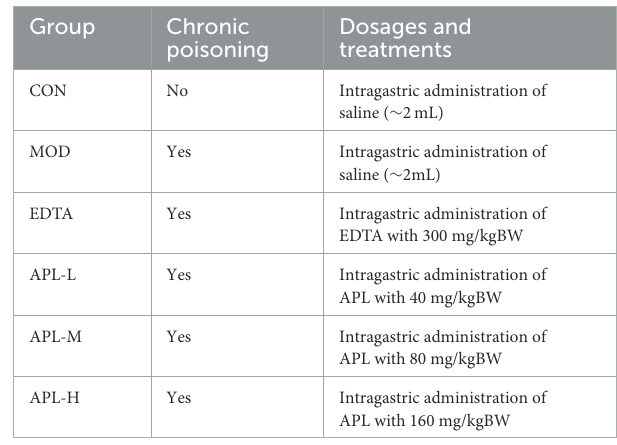
TABLE 1 Various treatments of rats in the chronic lead poisoning study for investigating the protective actions of EDTA(positive control) and various dosages of